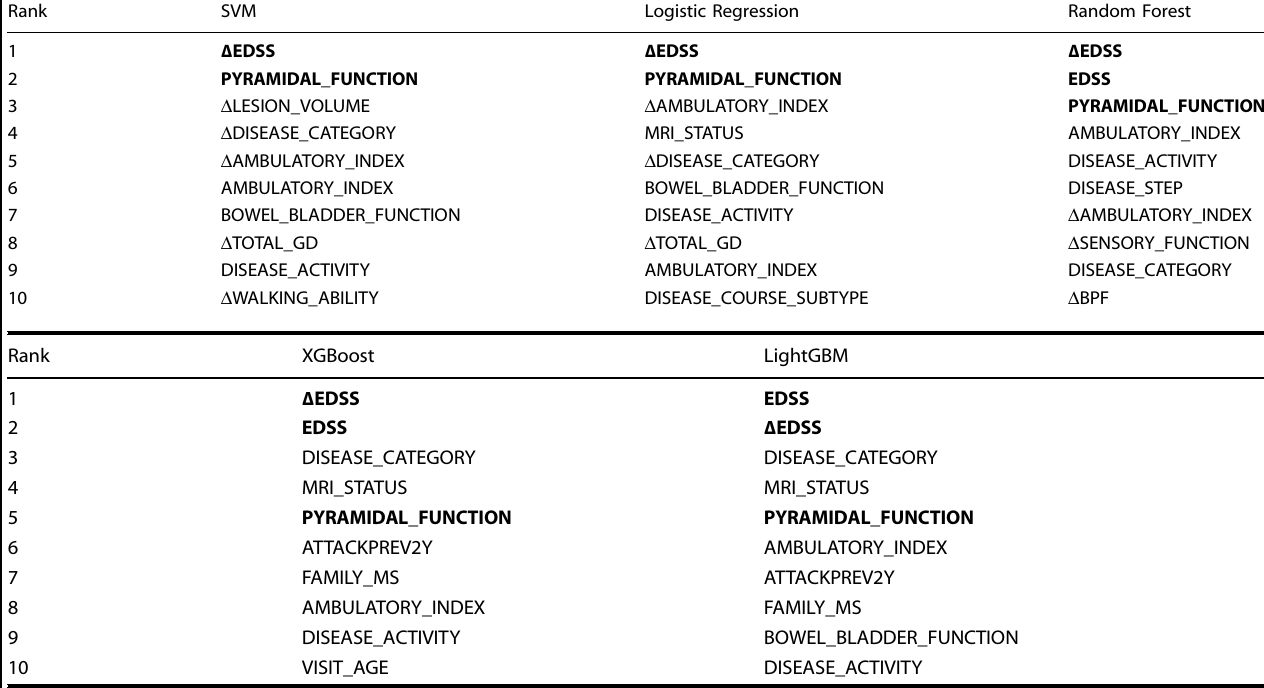
Table 4. Top ten predictive features identi fi ed by fi ve models using the CLIMB dataset.